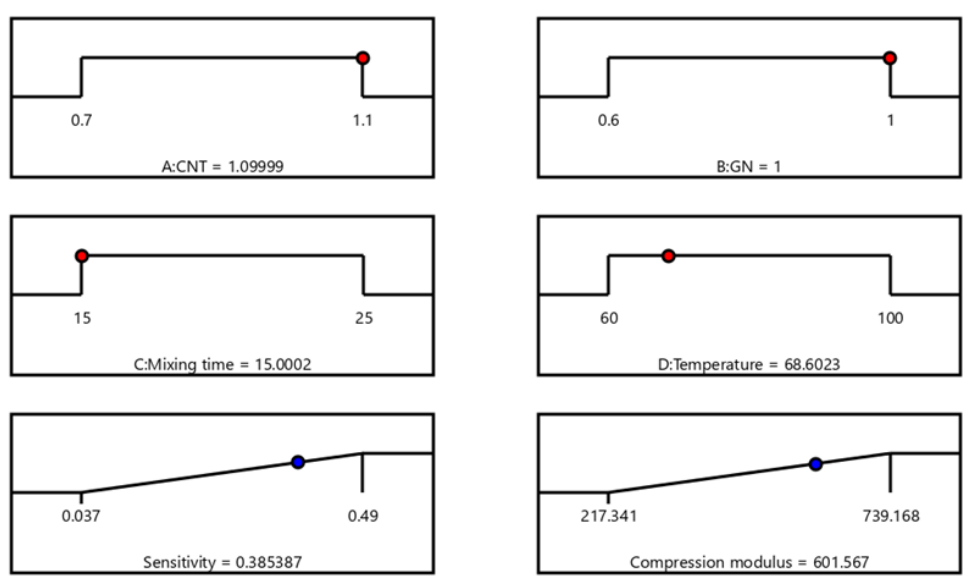
Figure 8. Desirability graph variables for the numerical optimization of four independent variables and two response values.